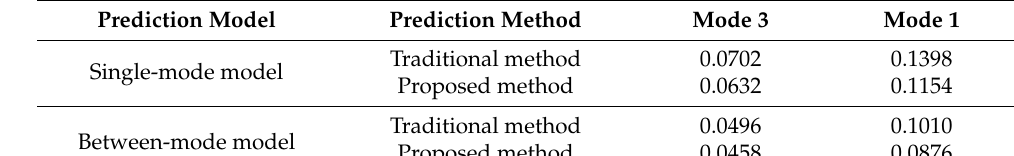
Figure 12. Multi-mode online prediction of mode 3.